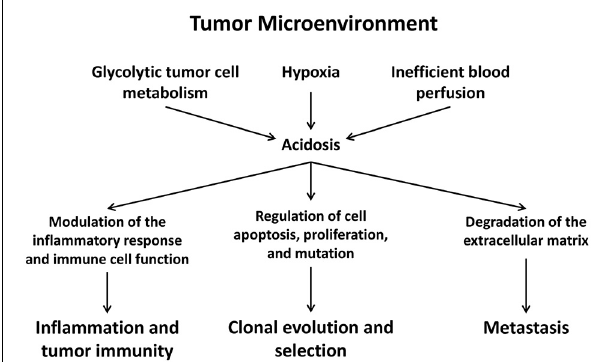
FIGURE 1 | The acidic tumor microenvironment regulates the proliferation, apoptosis, clonal evolution, and metastasis of cancer cells and modulates inflammation, anti-tumor immunity, and angiogenesis.